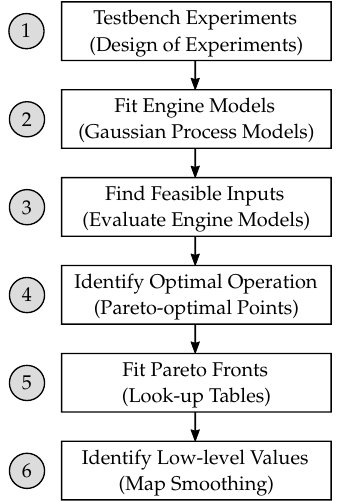
Figure 3. Workflow of the engine preoptimization. The general steps of the procedure are stated in the upper line of each block, while their specific implementation in this work is stated in parenthe- ses